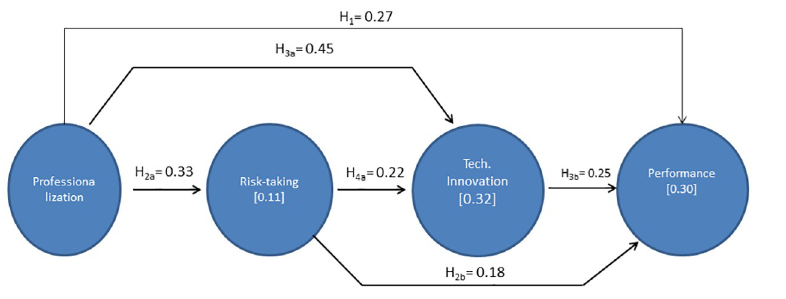
Fig 2. Results of SEM